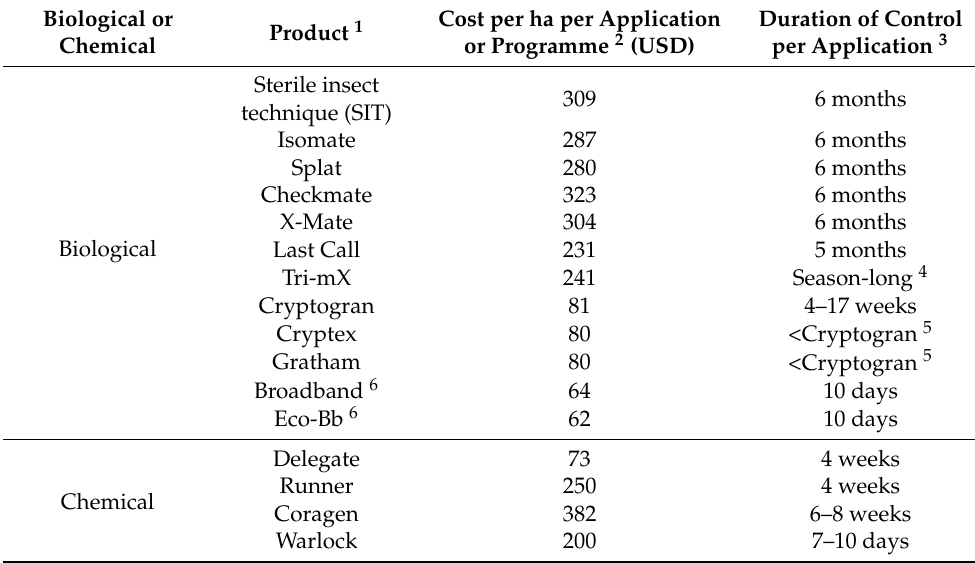
Table 2. Cost comparison between biopesticides and chemical pesticides for control of T. leucotreta in citrus in South Africa. Prices were obtained from three local suppliers and averaged where necessary. Biological